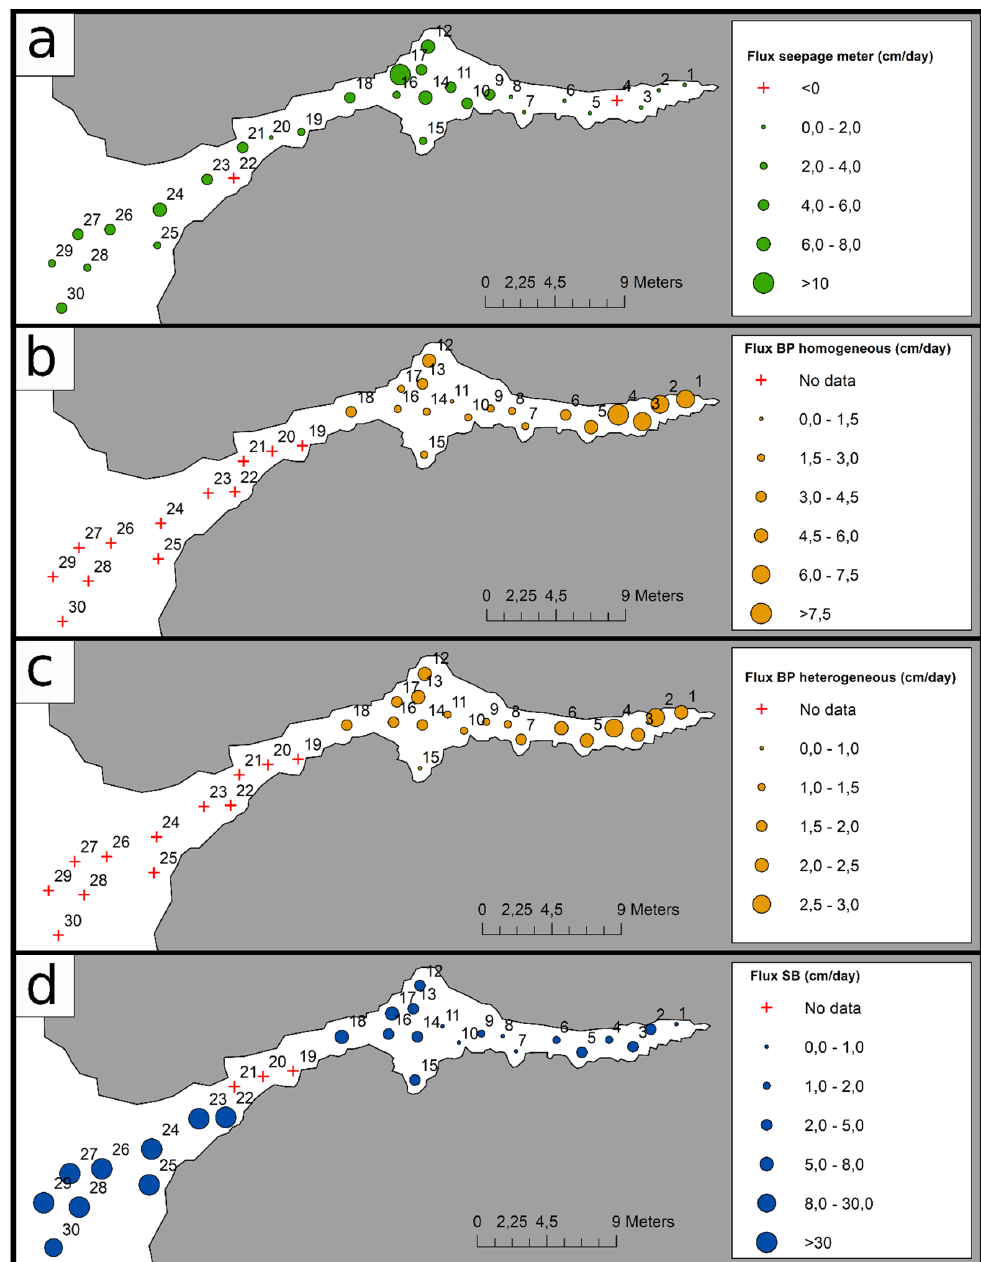
Figure 5. The spatial distribution of the measured and calculated exchange fluxes: ( a ) The mean from seepage meters, ( b ) calculated with the Bredehoeft and Papadopulos (1965) method for the homogeneous scenario, ( c ) calculated with the Bredehoeft and Papadopulos (1965) method for the heterogeneous scenario and ( d ) calculated with the Shan and Bodvarsson (2004)